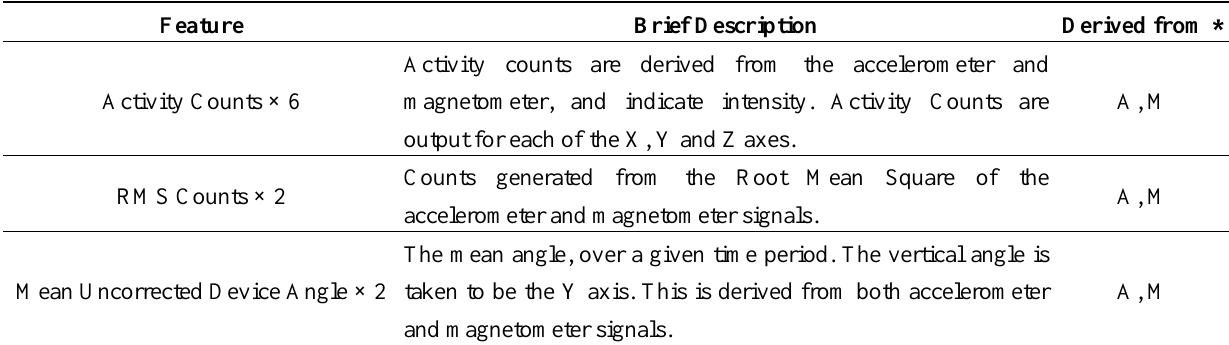
Table 1. Features computed from smartphone